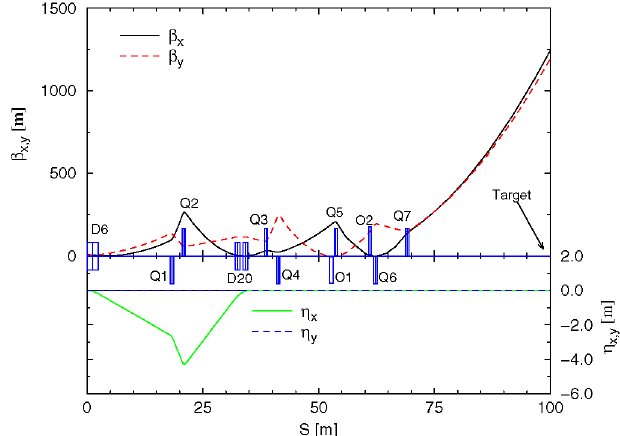
; (cid:2) ) and x y , along y